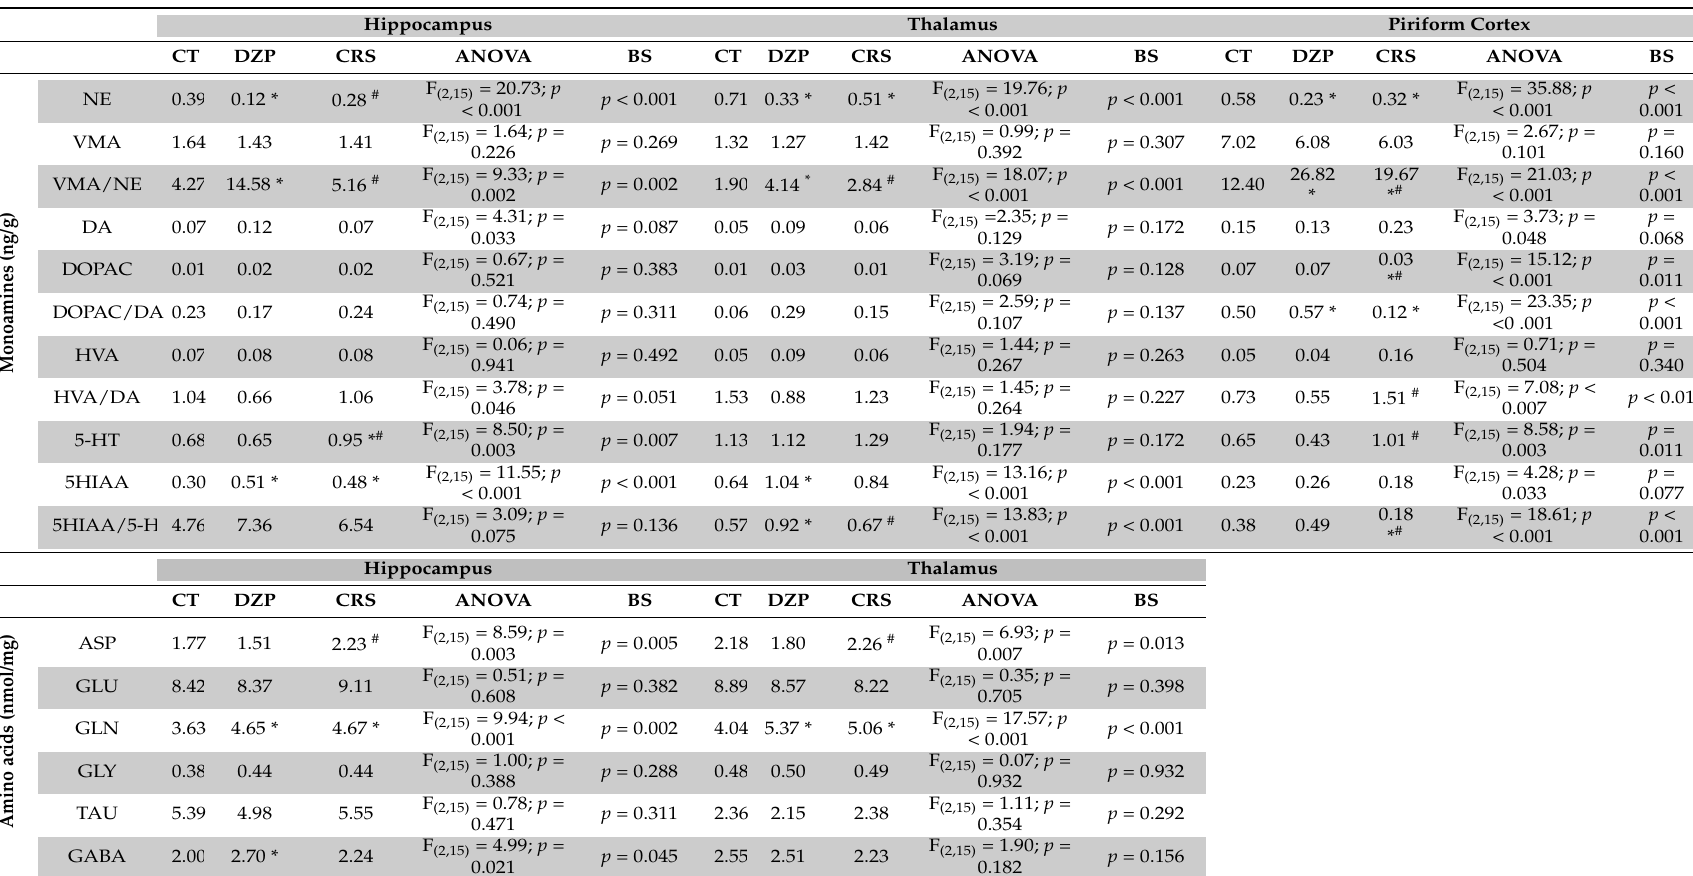
Table 1. Effect of status epilepticus (SE) and CRS treatment on the monoamine and amino acid levels in the hippocampus, thalamus, and piriform